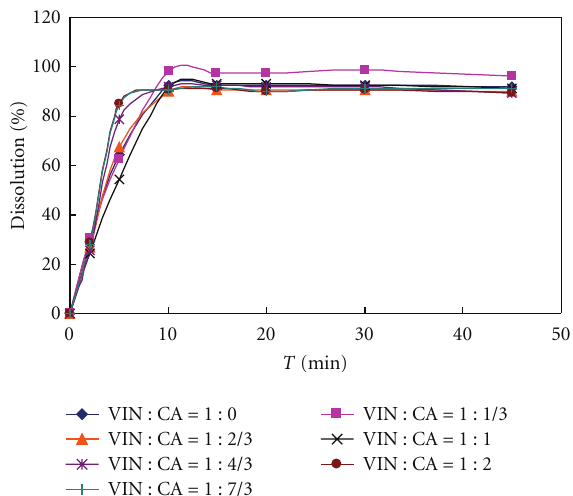
Figure 4: Influence of molar ratio of citric acid and vinpocetine on drug release profile (coating tablets in 0.1 N HCL); VIN: vinpocetine; CA: citric acid.